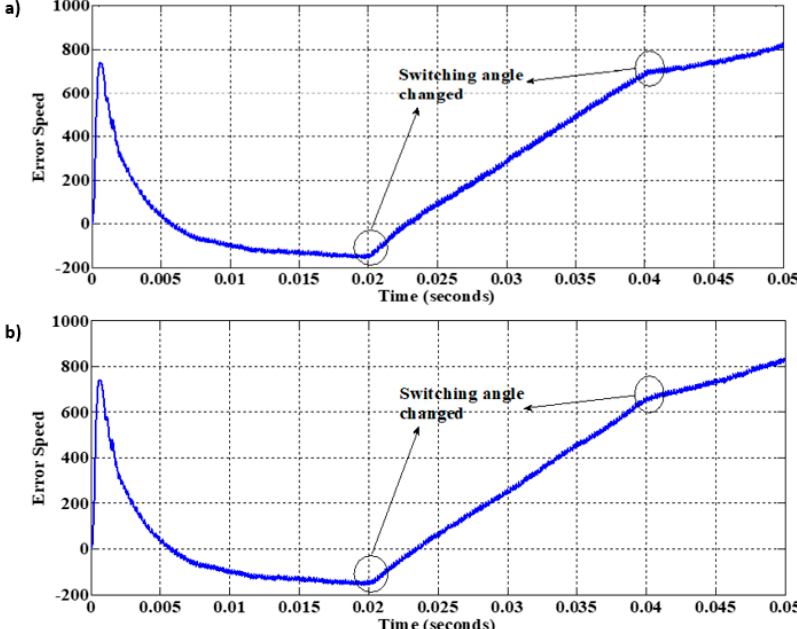
Figure 23. ( a ) Speed-tracking error when switching angle is changed to 11 degrees ( b ) Speed- tracking error when switching angle is changed to 13 degrees